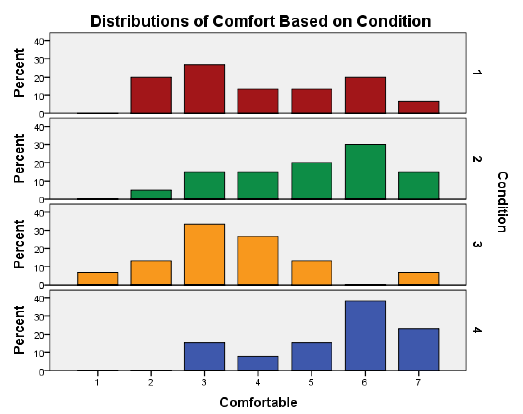
Figure 3: Distribution of participants’ evaluation of how comfortable they were during the experiment